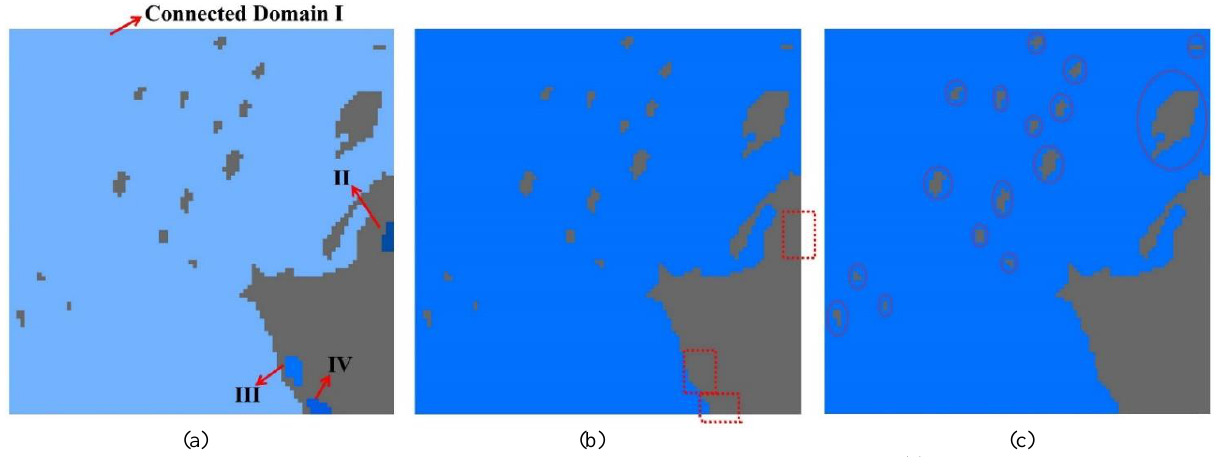
Fig. 4 Schematic diagram of ship areas proposal based on the water pixels labeling results, where (a) represents the extracted water pixels, (b) represents separation results of land and sea, and (c) represents ship areas proposal